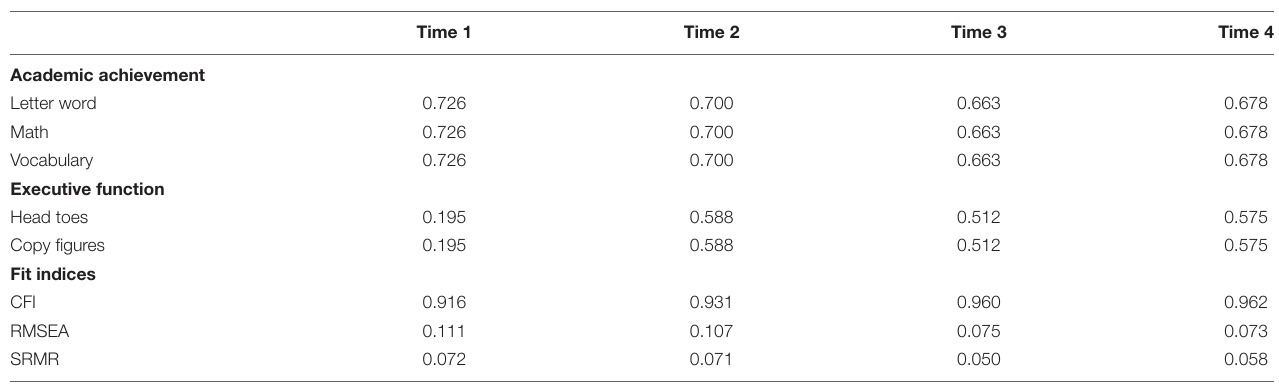
TABLE A2 | Factor loadings and fit indices for academic achievement and executive function: